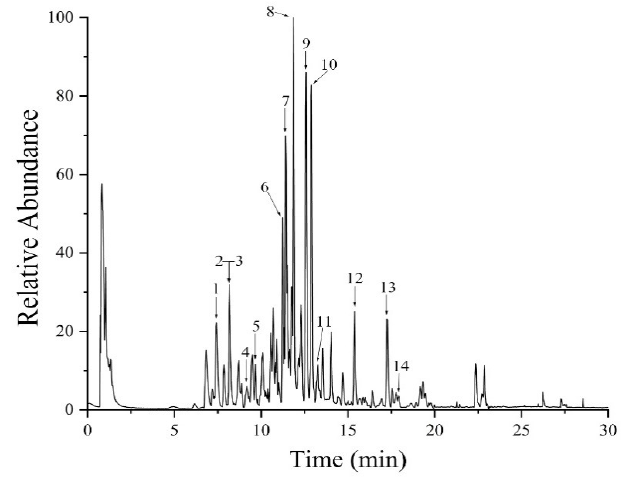
Figure 1. UHPLC-MS TIC of MCE. (Numbers 1–14 represent the chromatographic peaks of 14 compounds. The 14 compounds are Momordicoside O (1), Momordicoside E (2), Momordicoside S (3), Momordicoside A (4), Goyaglycoside h (5), Momorcharaside B (6), Momordicoside Q/Karaviloside XI (7), Momorcharaside M/N/Karaviloside Ⅹ (8), Goyasaponin I (9), Goyasaponin II (10), Goyalycoside e/f (11), Momordicoside L (12), Momordicoside P (13) and Momordicin II (14) respectively.). Finally, a total of 14 major compounds, triterpenoids, were identified in MCE. The m / z values of the ions are expressed as integers to facilitate the statement in discussion. The gly ‐ cosides of these triterpenoids are normally composed of β‐ D ‐ glucopyranosyl ( β‐ D ‐ Glc), β‐ D ‐ xylopyranosyl ( β‐ D ‐ Xyl), β‐ D ‐ galactopyranosyl ( β‐ D ‐ gal), α‐ L ‐ rhamnopyranosyl ( α‐ L ‐ Rha), β‐ D ‐ fucopyranosyl ( β‐ D ‐ Fuc) and β‐ D ‐ allopyranosyl ( β‐ D ‐ All), or in the form of disaccha ‐